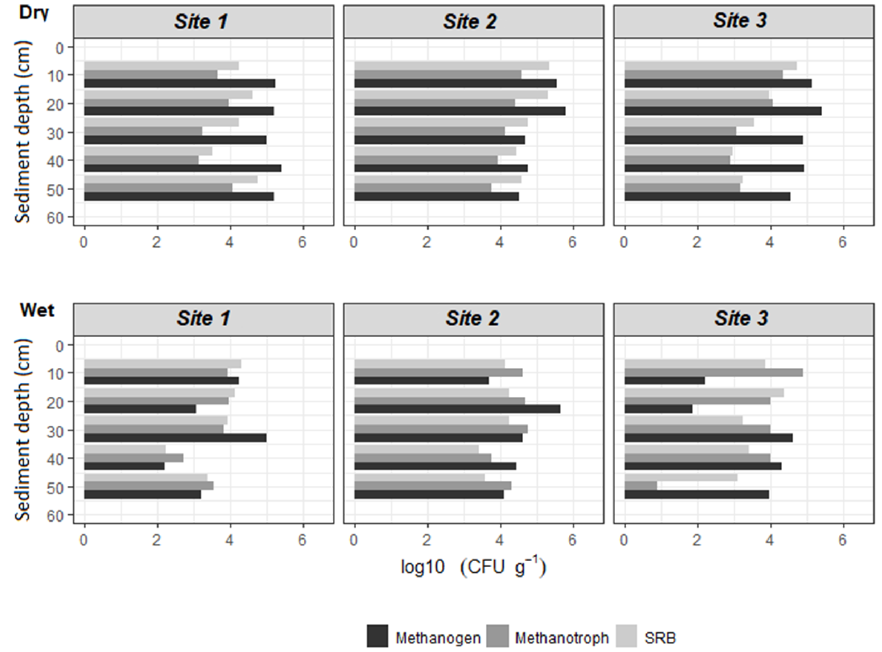
Figure 2. The relative abundances of archaea/bacteria groups (methanogens, methanotrophs, and SRBs) from the qPCR method. Panels represent the three selected sites. Sediment samples were collected in the dry and wet seasons.